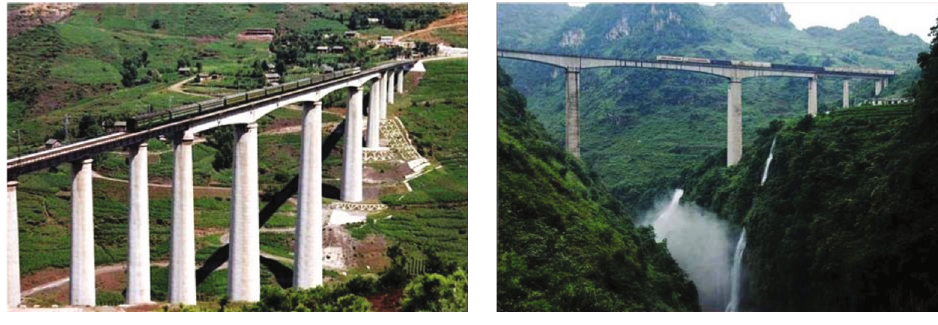
Figure 1: Application of continuous rigid-frame bridge in road construction.